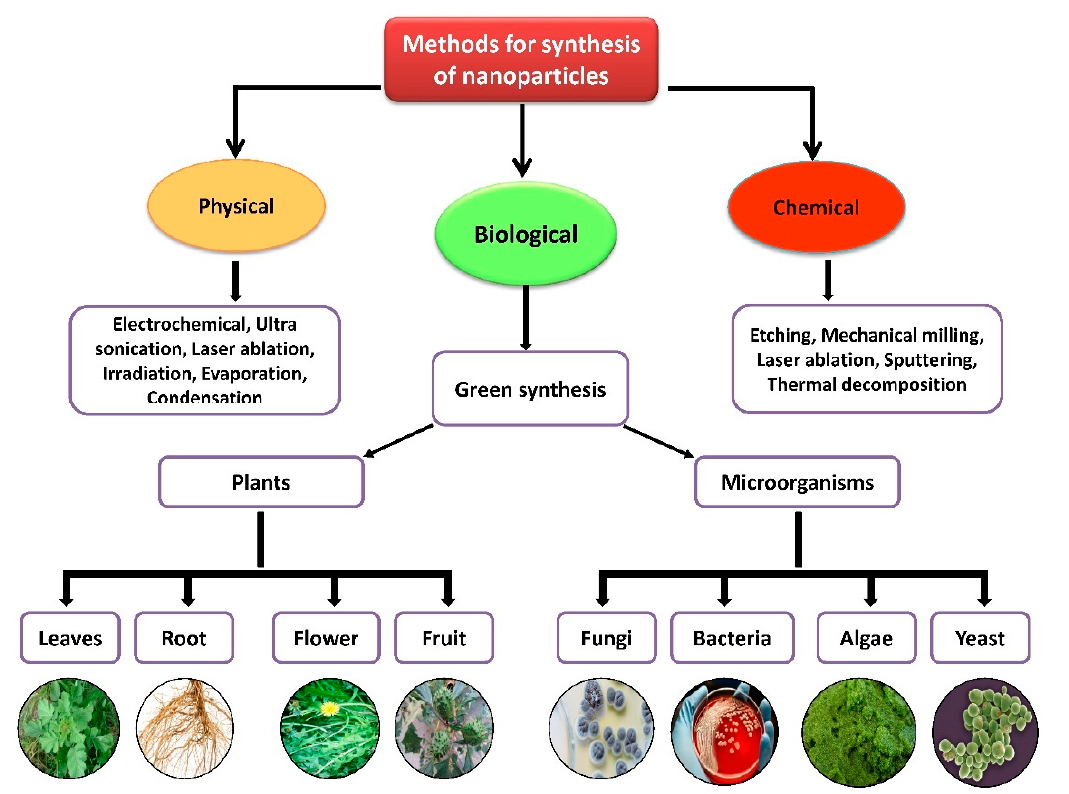
Figure 2. Different methods of nanoparticle synthesis.